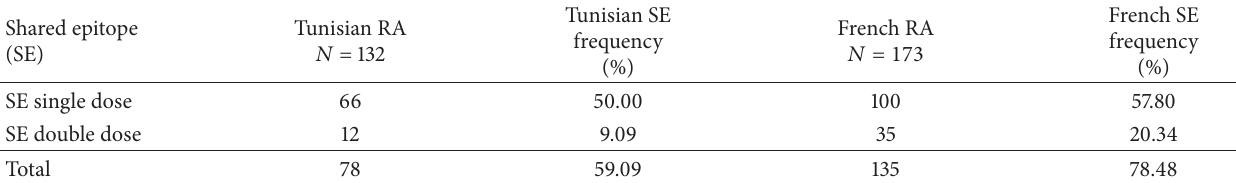
Table 3: Shared epitope single dose/double dose frequency in Tunisian and French RA women.